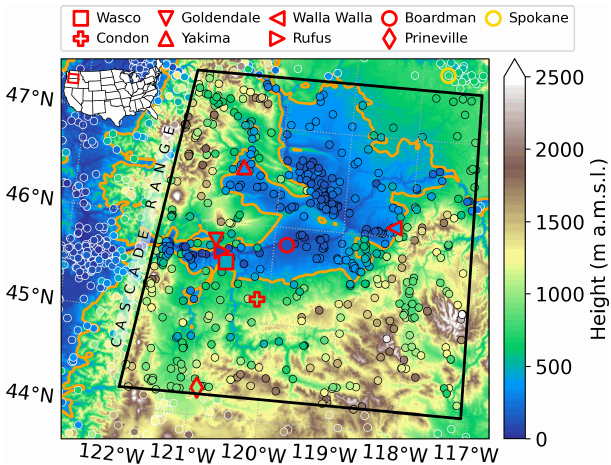
Figure 1. Terrain height in the investigation area and location of sta- tions with profile and radiation flux measurements from the WFIP2 campaign (red markers) and from the MesoWest repository (black and white circles). The fill color of each marker indicates the station height. Stations within the black-outlined polygon (red markers and black circles) are used for the model evaluation. The yellow cir- cle indicates the location of the radiosonde station at Spokane. The 500m terrain contour is given by the orange isoline. Terrain data are from the d02 runs with a 750m horizontal grid spacing. The inset plot in the upper-left corner shows the location of the investigation area in the United